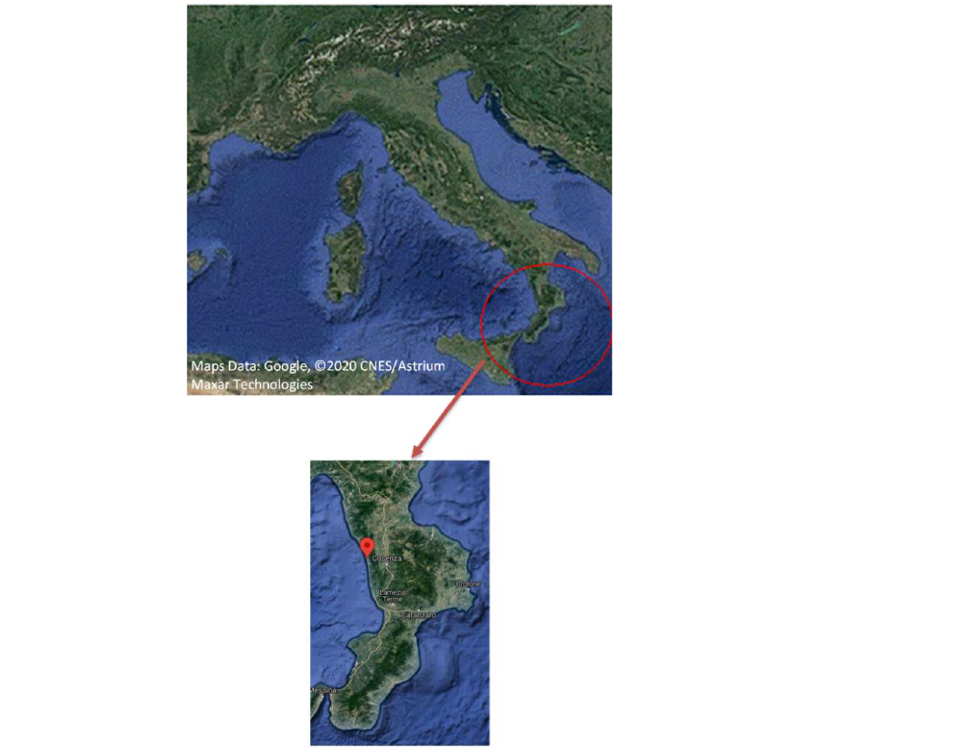
Figure 1. The map of the Calabria region, southern Italy, with the sampling point indicated.